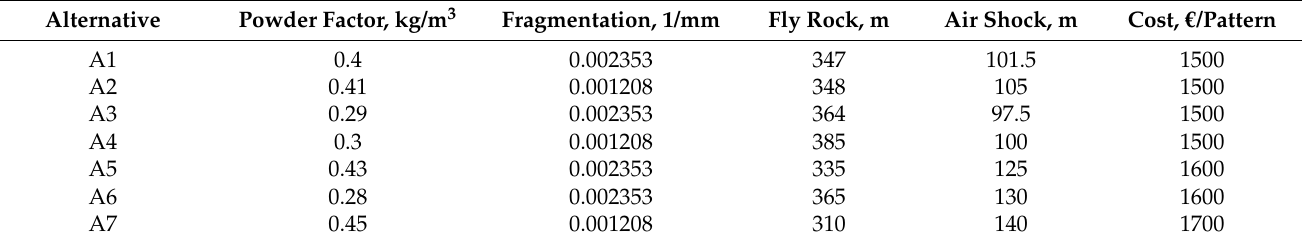
Table 3. Criteria used for selecting optimal blasting